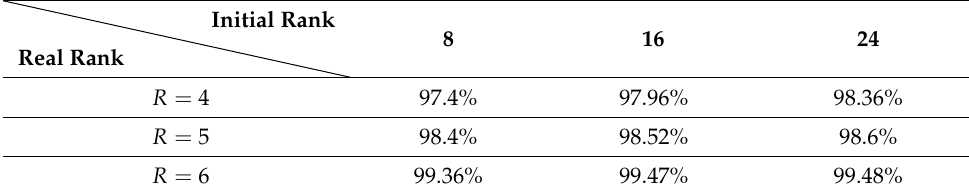
Table 1. Robustness of the proposed method in success rate with different real rank.